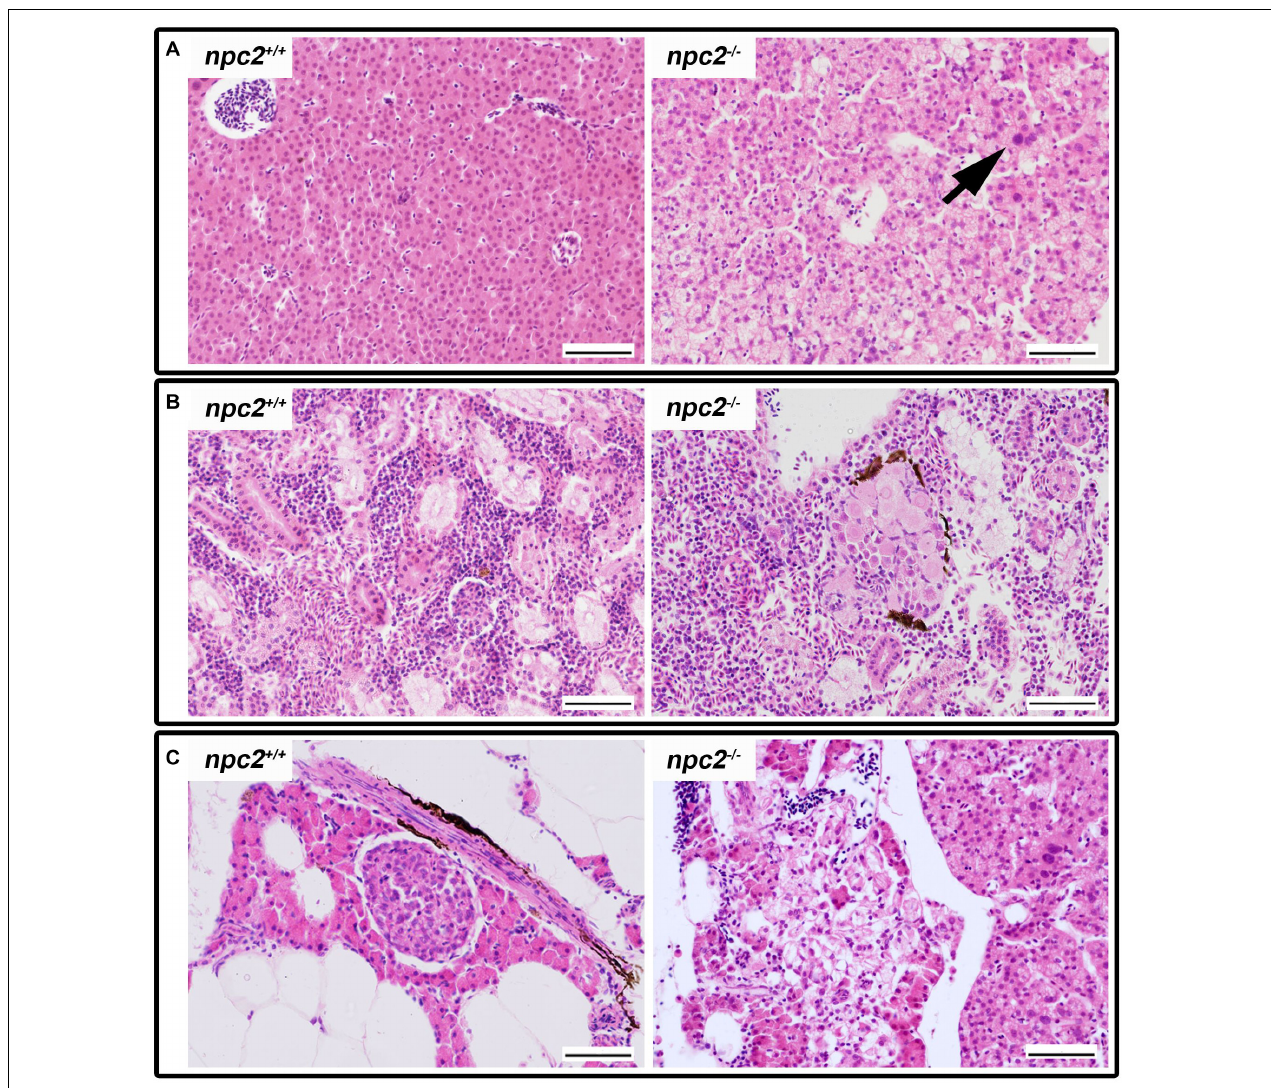
FIGURE 5 | Pathological changes in soft tissues in npc2 − / − revealed by H&E staining. (A) Cells with enlarged nuclei (black arrow), hepatosteatosis with different type of fatty droplet accumulation (open arrowhead) and foam cytoplasm (asterix) were found in npc2 -deficient livers. (B) Kidneys with degenerating cells (DMc) between ductal (DT) and proximal (PT) tubules. (C) Pancreas with degeneration of zymogen granules in acinar cells and cholesterol deposits. The paraffin sections are from adult npc2 − / − fish and wildtype npc2 + / + control. Scale bar = 50 µ m.